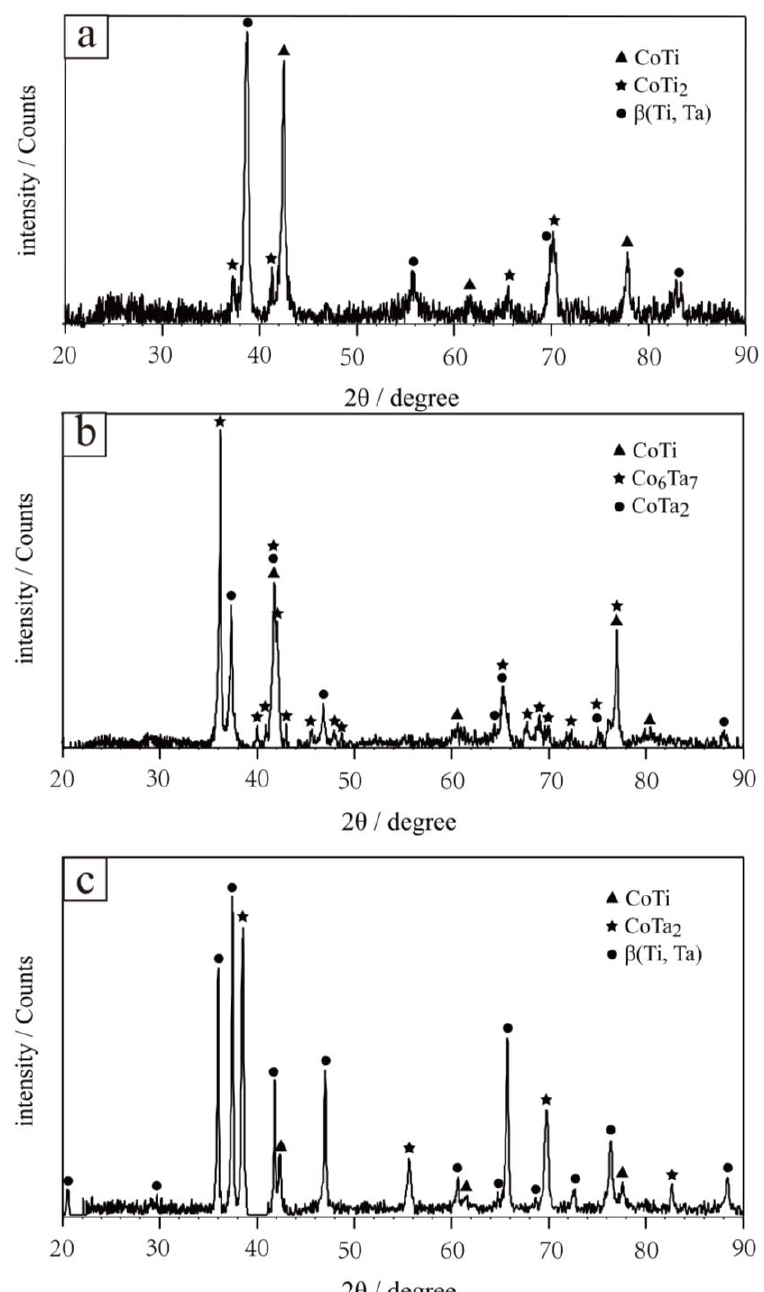
Figure 3. X-ray diffraction patterns obtained from: ( a ) Co 30 Ti 50 Ta 20 alloy annealed at 1000 °C for 45 days; ( b ) Co 45 Ti 15 Ta 40 alloy annealed at 1100 °C for 35 days; and ( c ) Co 30 Ti 20 Ta 50 alloy annealed at 1100 °C for 35 days.